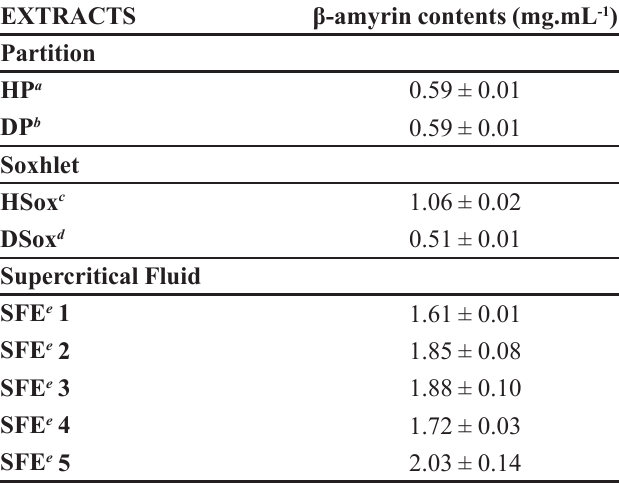
TABLE III - Quantification of β-amyrin in unpolar partitions and extracts from Passiflora mucronata leaves EXTRACTS